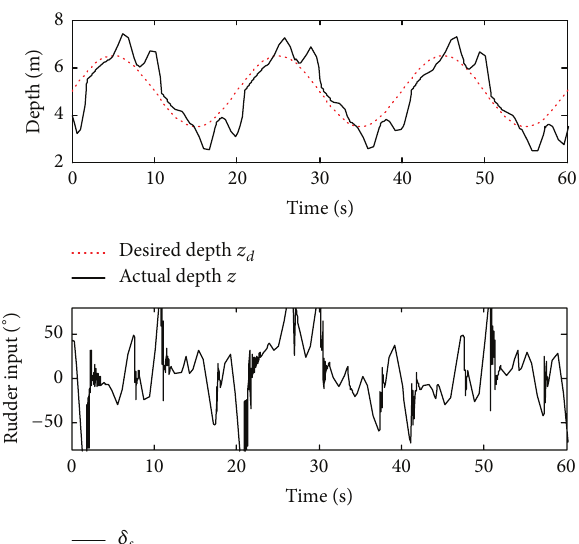
Figure 7: Sliding mode surfaces 𝑆 1 ,𝑆 2 , 𝑆 3 .